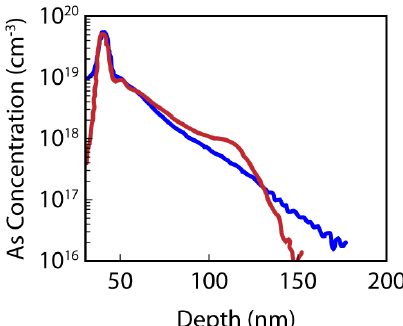
Figure 2. The determined arsenic concentration profiles with respect to depth for arsenic-doped (blue line 3 × 10 13 As/cm 2 with 50 keV implantation energy) and fluorine + arsenic-co-doped (red line As: 3 × 10 13 As/cm 2 with 50 keV implantation energy; F: 1 × 10 15 F/cm 2 with 35 keV implantation energy) 3 × 10 13 As / cm 2 with 50 keV implantation energy; F: 1 × 10 15 F / cm 2 with 35 keV implantation energy) germanium [38]. germanium